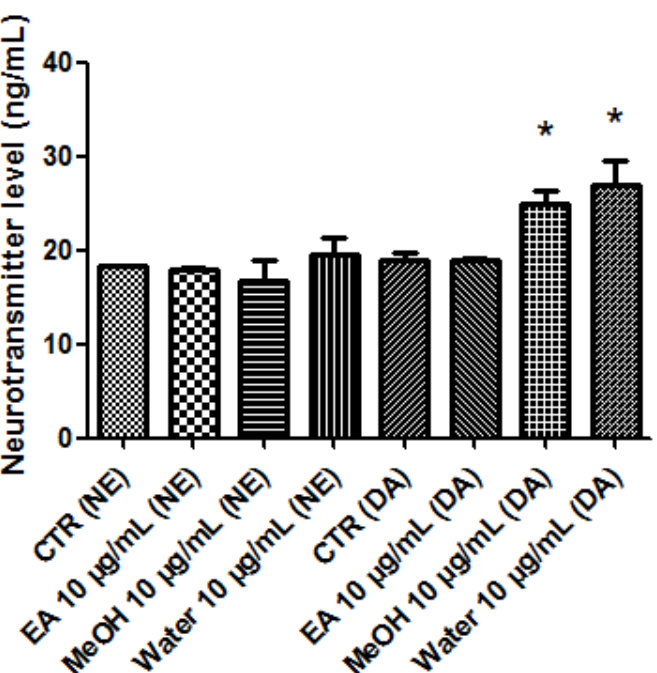
Figure 3. Effects of P. africanum water, methanol (MeOH), and ethylacetate (EA) extracts (10 μ g/mL) on extracellular levels (ng/mL) of dopamine (DA) and norepinephrine (NE). Neurotransmitters were measured in the medium of hypothalamic HypoE22 cells stimulated with extracts in basal conditions. ANOVA, p < 0.05; post hoc test, * p < 0.05 vs. CTR group.